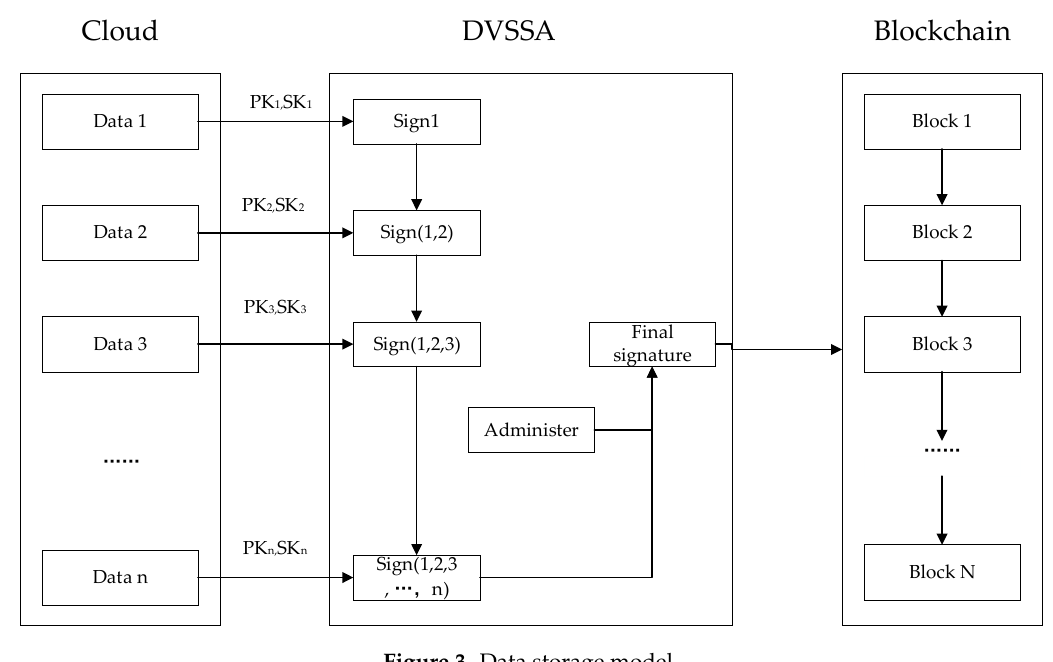
Figure 3. Data storage model.